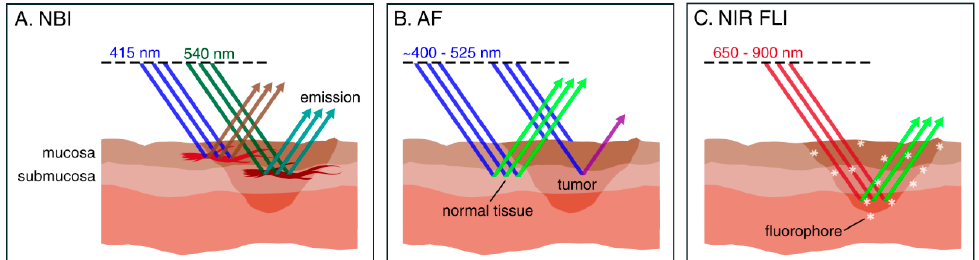
Figure 1. Schematic representation of fluorescence-based imaging working principles. ( A ) Narrow-band imaging (NBI): NBI light consists of two wavelengths: 415 nm blue and 540 nm green light. The blue light penetrates the mucosa, increasing contrast in these capillaries (appearing brown), whereas the green light reaches the submucosa, visualizing the vasculature in these deeper layers (appearing dark green). ( B ) Autofluorescence (AF) imaging: When exposed to blue light, healthy laryngeal mucosa emits green fluorescence, whereas neoplastic mucosa emits both light of lower energy (red-violet) and heat. ( C ) Near-infrared (NIR) fluorescence imaging (FLI): When exposed to NIR light, previously administered fluorophores emit light of a wavelength, which is specific to the fluorophore (e.g., excitation and emission wavelengths for ICG: ~780 and 820 nm, respectively). Penetration depth of light in the NIR spectrum ranges from 0.5 to more than 10 mm, contingent to the wavelength.